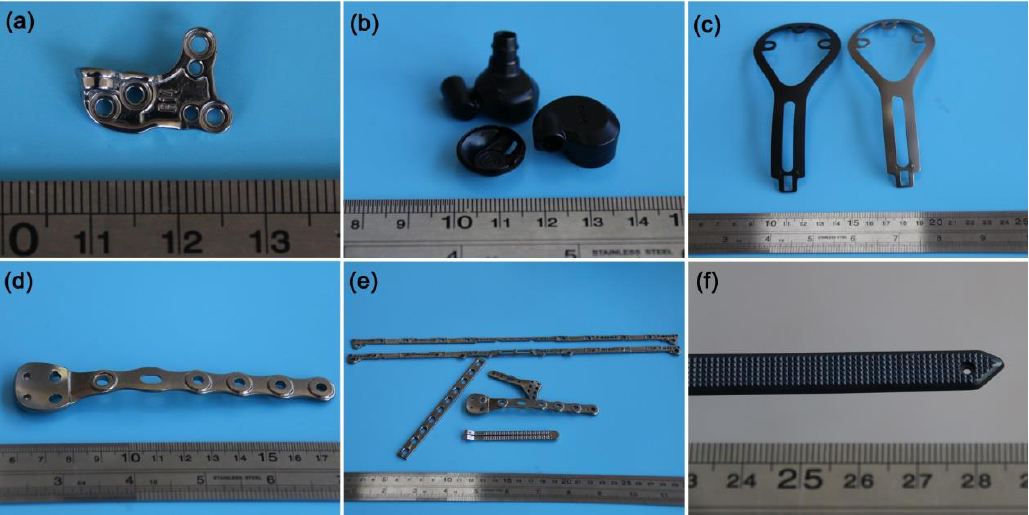
Figure 7. BMG parts with various shapes and used in different fields: ( a ) BMG transmission used in a notebook computer fabricated by Vit106; ( b ) thin-walled and hollow BMG earphones (Vit106); ( c ) Vit 106 thin-walled BMG samples coated in different colors; ( d–f ) biomedical implants fabricated using Vit105 BMGs.